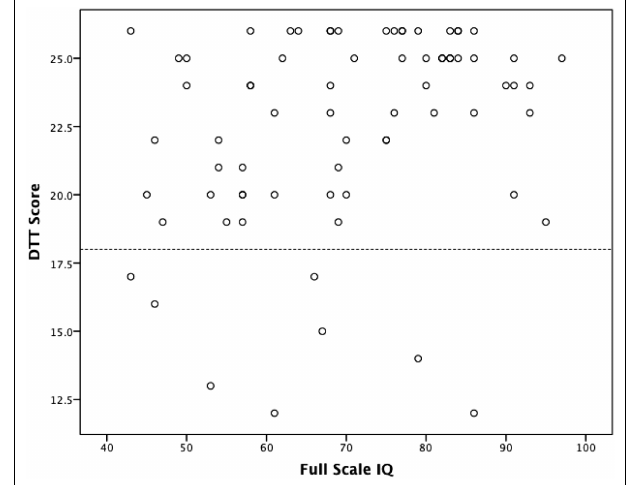
FIGURE 2 | Relationship between distorted tunes test (DTT) and IQ. Scores below the dashed line are in the range of amusia ( ≤ 18).There was a moderate association between DTT and IQ ( ρ = 0.306, p =